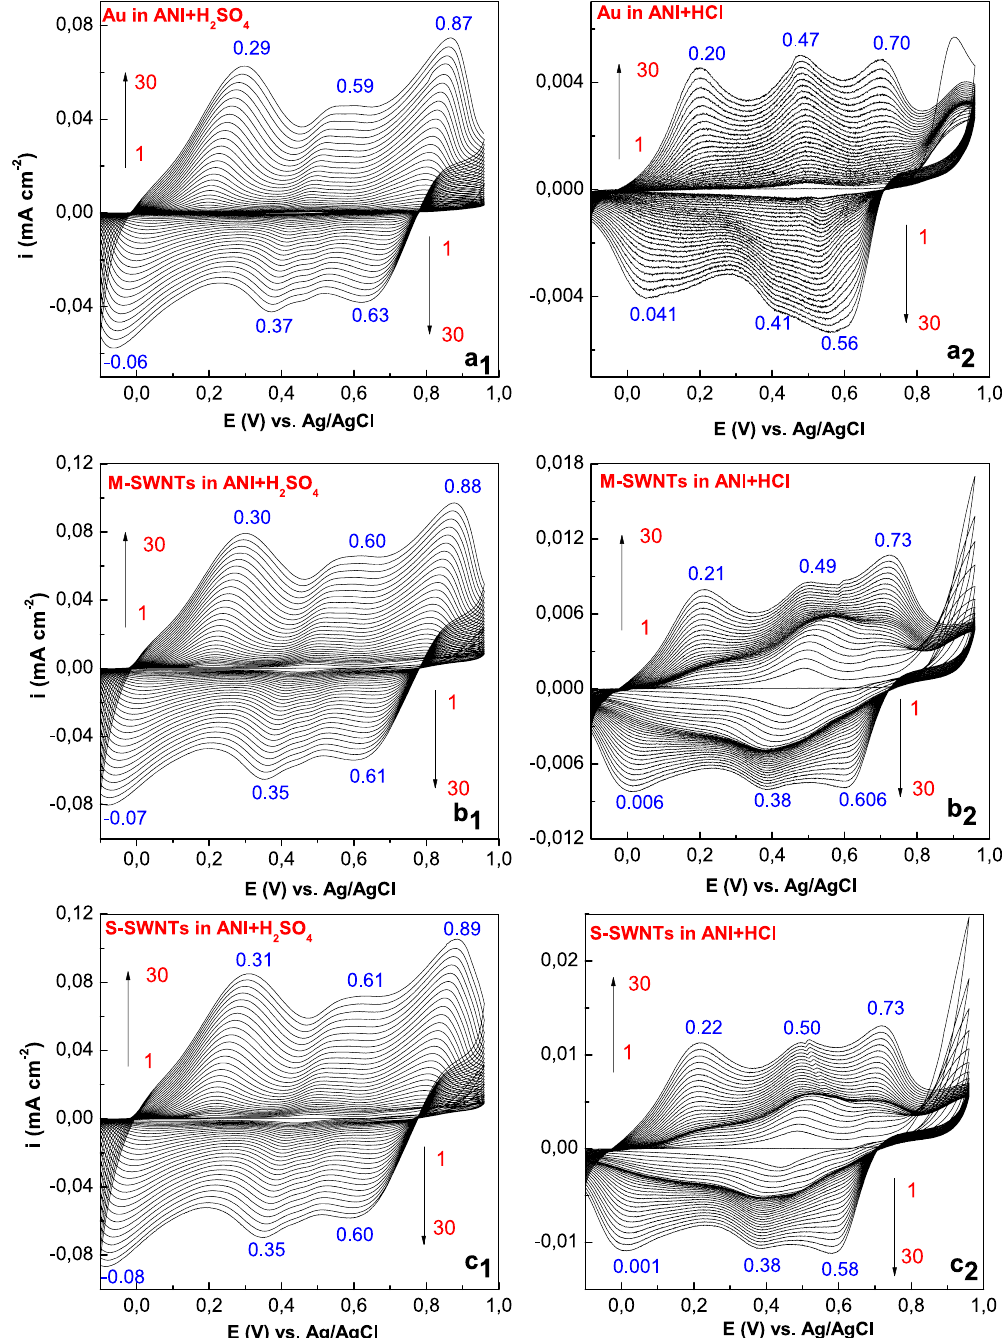
Figure 1. CVs describing the ANI electropolymerization, in the presence of the H 2 SO 4 and HCl solutions, are recorded onto the blank Au electrode ( a 1 , a 2 ) and the Au plates covered with M-SWNT ( b 1 , b 2 ), and S-SWNT ( c 1 , c 2 ) films,